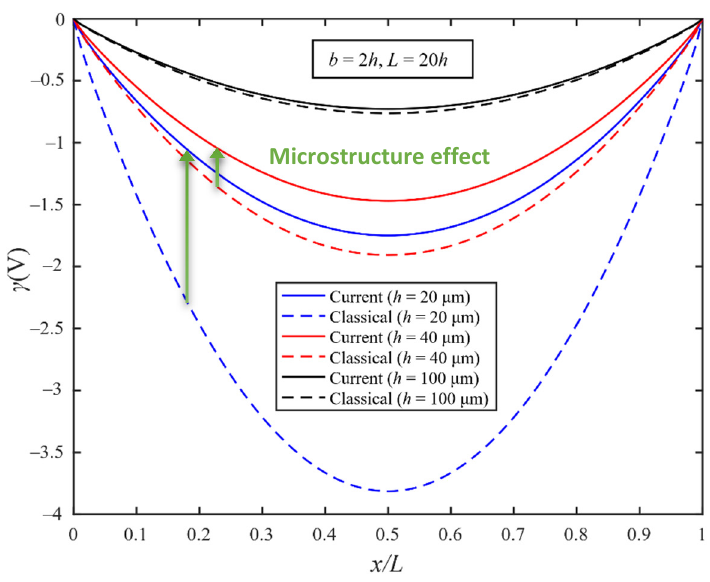
Figure 7. Electric potential of the MEE-FGM simply supported beam (Gradient index n = 5).